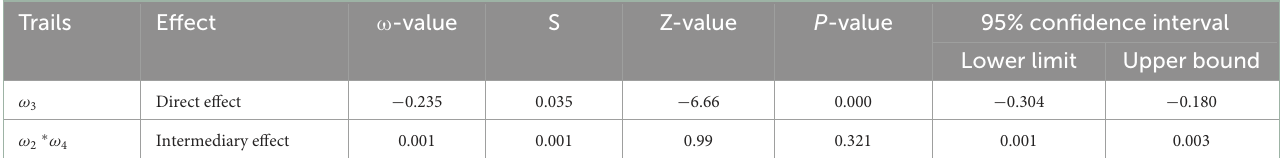
TABLE 10 Bootstrap test: Total factor